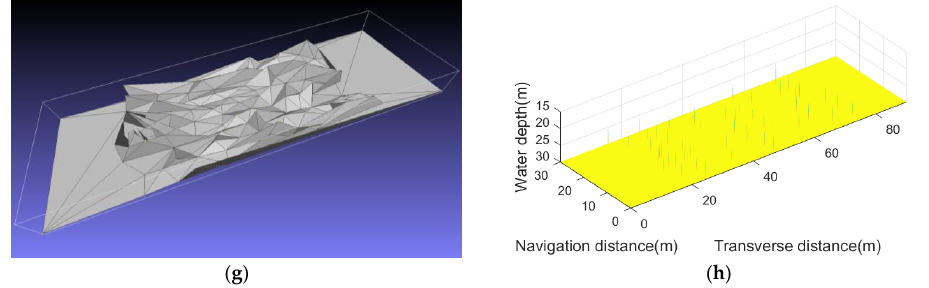
Figure 12. Simulation results under different simplification scales, where ( a , c , e , g ) are TM and ( b , d , f , h ) are the corresponding extracted point cloud: ( a , b ) are the original model composed of 42,936 data points; ( c , d ) are simplified to 3000 data points; ( e , f ) are simplified to 1000 data points; ( g , h ) are simplified to 176 data points.